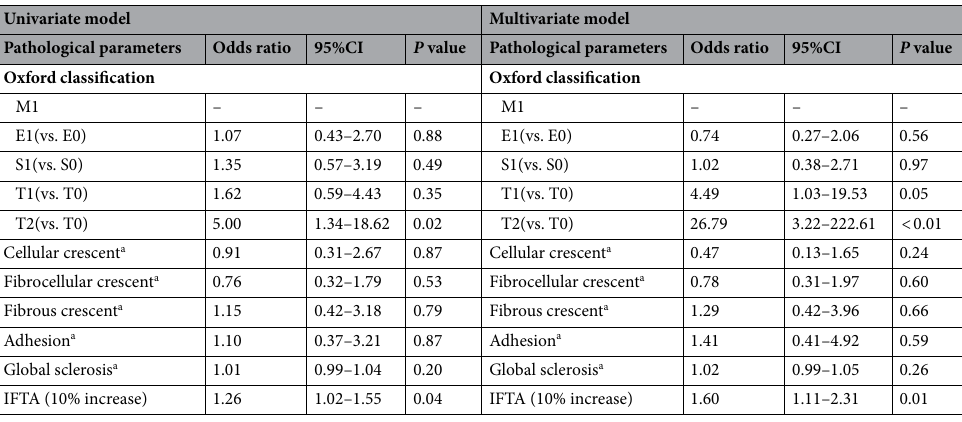
Table 5. Logistic regression analysis of the renal outcome. Oxford classification; M1, Mesangial hypercellularity score > 0.5; E1, any endocapillary hypercellularity; S1, any segmental sclerosis; T, tubular reference.